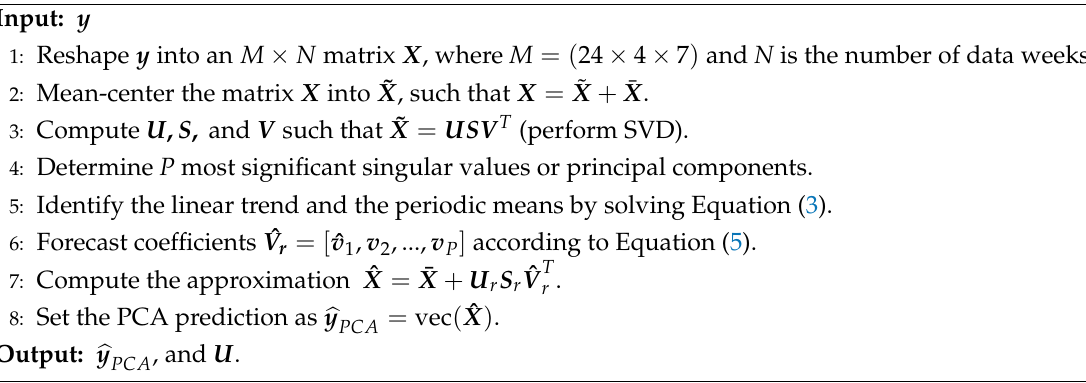
Algorithm 1 PCA-based algorithm for electrical load